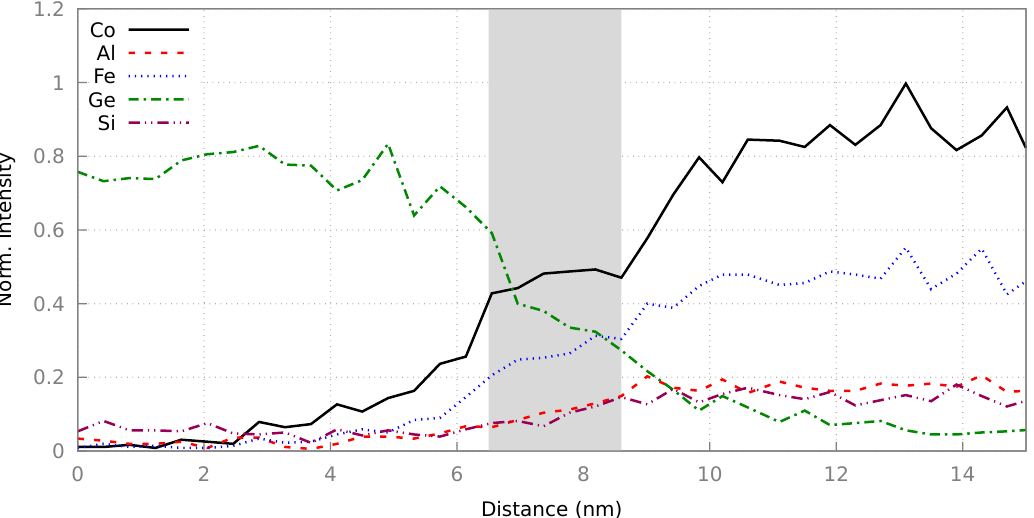
Figure 9. EDS results across the annealed CFAS/ n -Ge interface, showing significant mixing of the atomic species. Plateaux can be seen around 6.5–8.6 nm in Co, Fe and Ge, indicated by the shaded region. Data taken from Kuerbanjian et al.